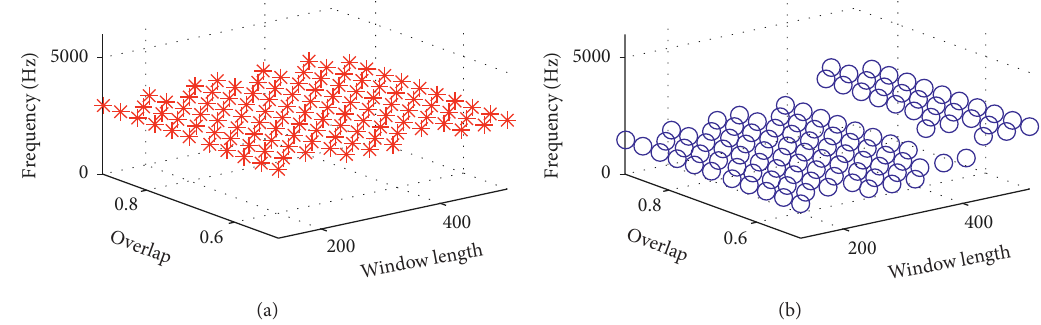
Figure 22: ICFs located by the proposed method and EFS with the experimental signal in Figure 21(a). (a) Envelope negentropy. (b) Energy fluctuation.